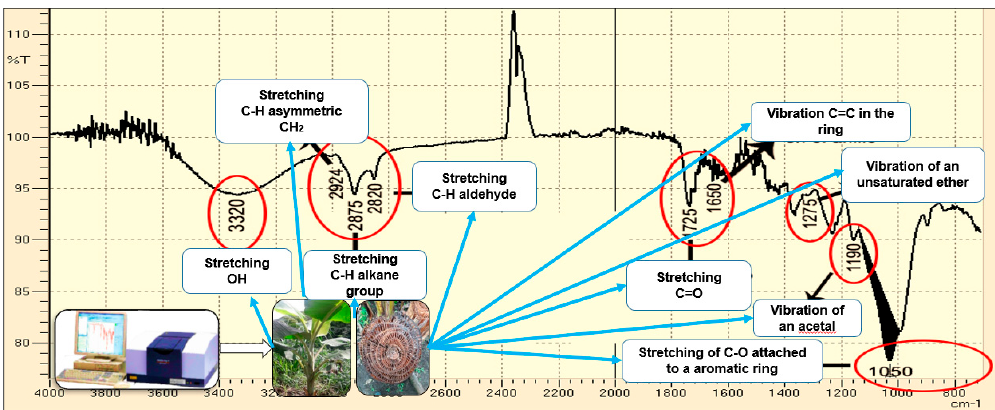
Figure 2. IR spectrum of the banana pseudo-stem taken on Shimadzu brand IR AFFINITY-1S equipment with the ATR technique of Total Attenuated Reflection.